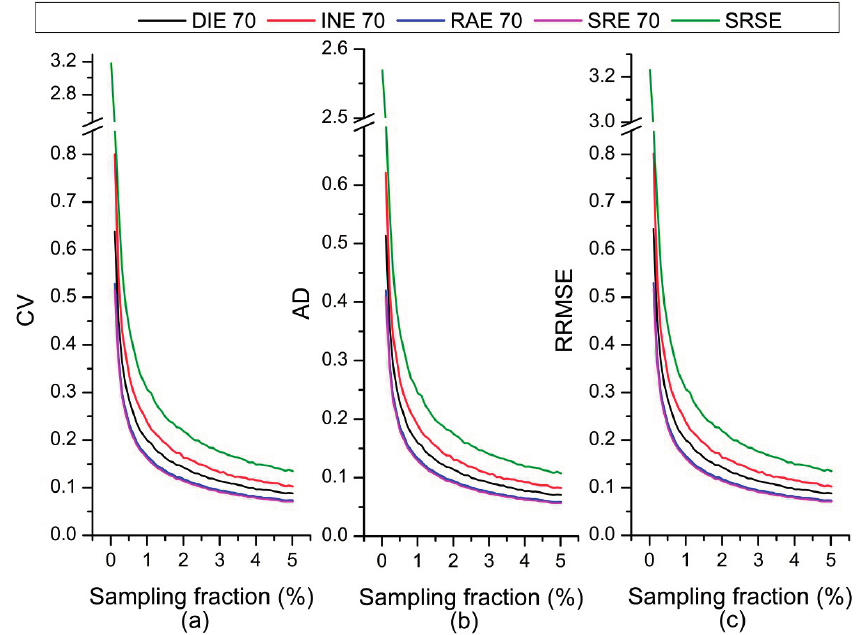
Figure 6. Comparison of coefficient of variance CV ( a ), average deviation AD ( b ), and relative root mean square error RRMSE ( c ) at various sampling fractions (overall accuracy of classification =